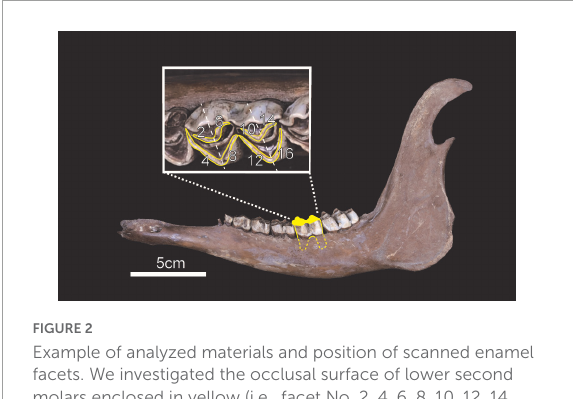
FIGURE2 Example of analyzed materials and position of scanned enamel facets. We investigated the occlusal surface of lower second molars enclosed in yellow (i.e., facet No. 2, 4, 6, 8, 10, 12, 14, and